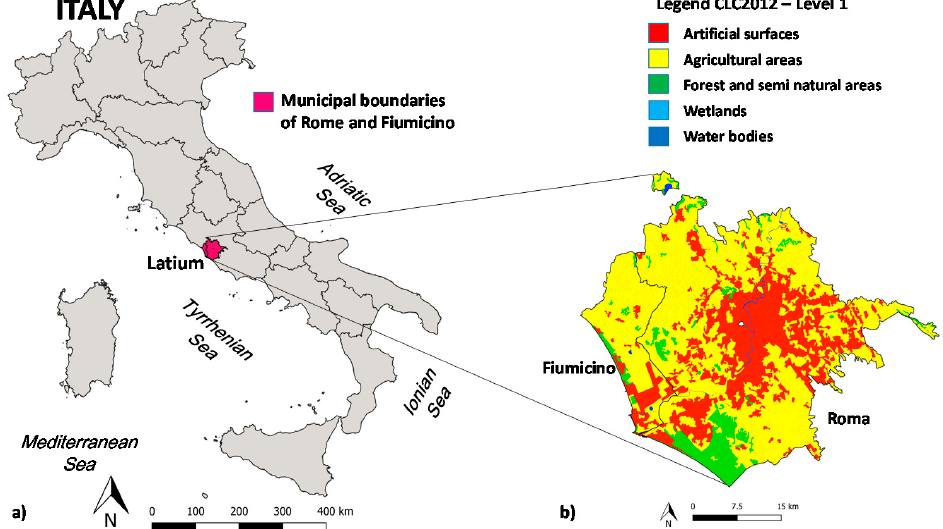
Figure 2. ( a ) Italy subdivided into 20 regions (NUTS Level 2, Nomenclature of territorial units for statistics – regions level) and the study area including the municipalities of Rome and Fiumicino within the Latium region (in purple); ( b ) Land cover map of the study area derived from the Corine Land Cover 2012 – Level 1.